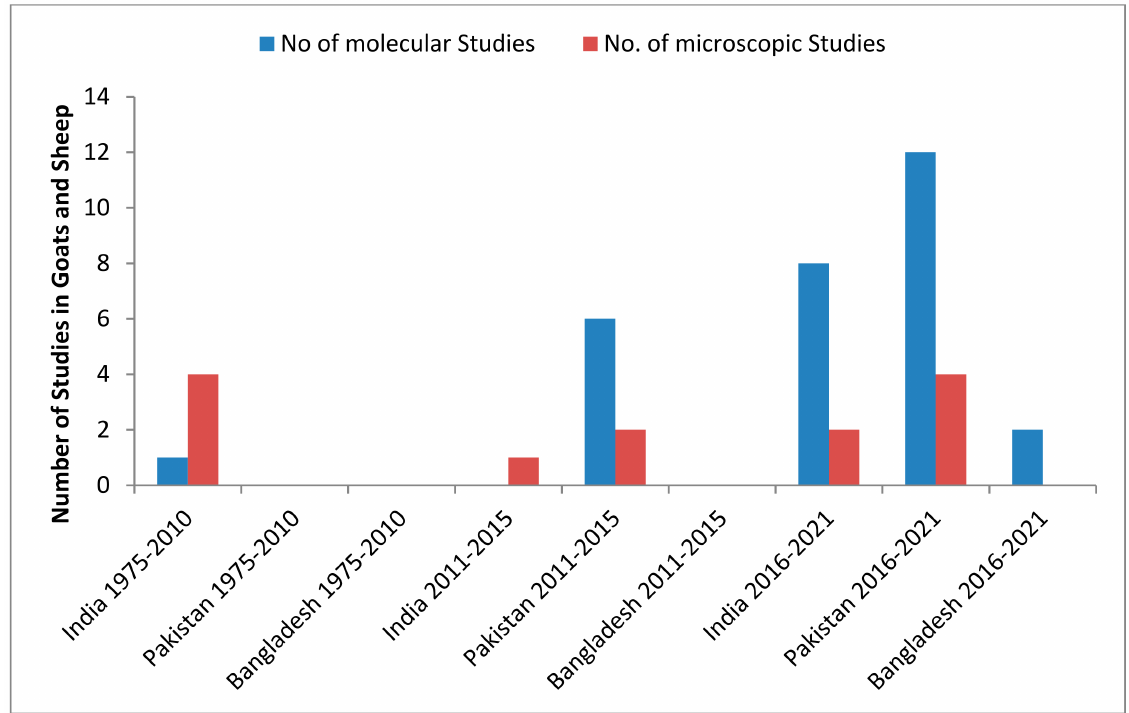
Figure 5. Comparison of the number of epidemiological studies detecting Theileria spp. in goats and sheep using molecular and microscopic diagnostic methods in India, Pakistan and Bangladesh, according to three different periods between 1975 and